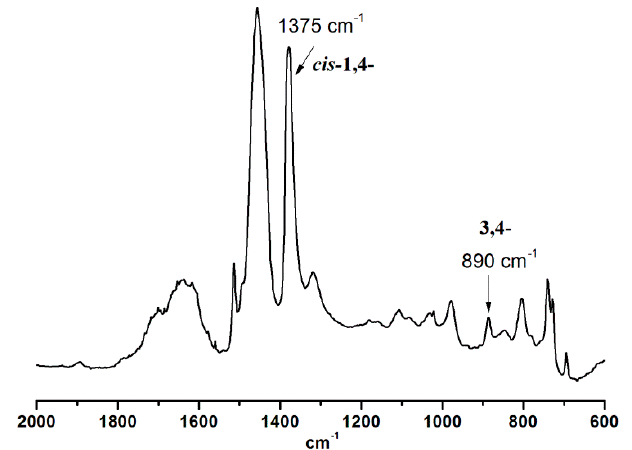
Figure 4. FTIR spectra of polyisoprenes obtained by Co(II) catalysts (entry 6).